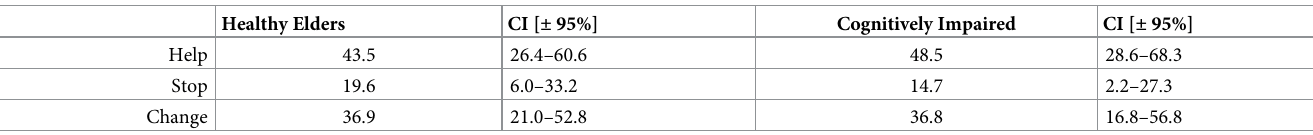
Table 4. Modification type (%) by